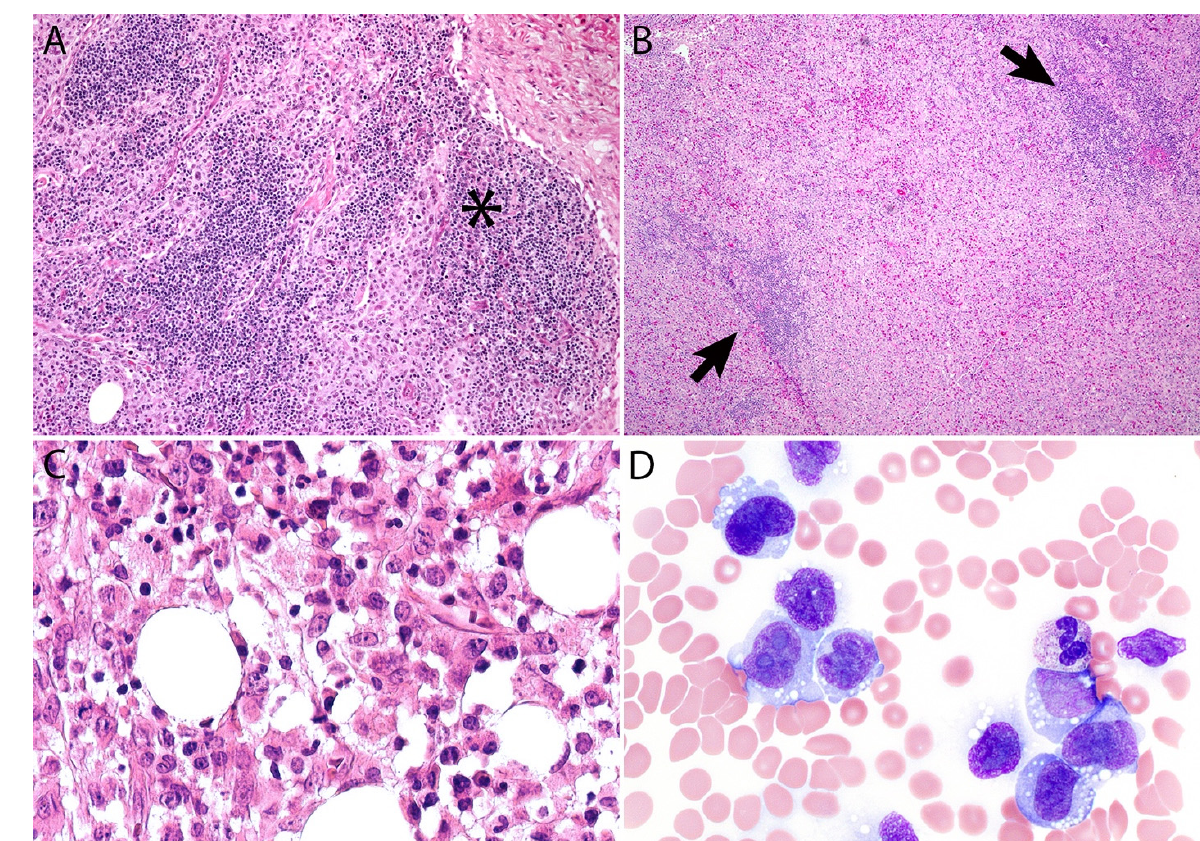
Figure 2. ( A ) Sinusoidal distribution of ALCL mimicking metastatic carcinoma (asterisk). ( B ) ALCL with marked expansion of the paracortical area and subtotal effacement of a lymph node. The arrows point to residual compressed lymphoid follicles. ( C ) ALK- ALCL involving bone marrow. ( D ) Leukemic ALK- ALCL mimicking monocytic leukemia. The neoplastic cells are intermediate to large with an irregular to reniform nucleus (“hallmark” cells) and moderate to abundant vacuolated cytoplasm.